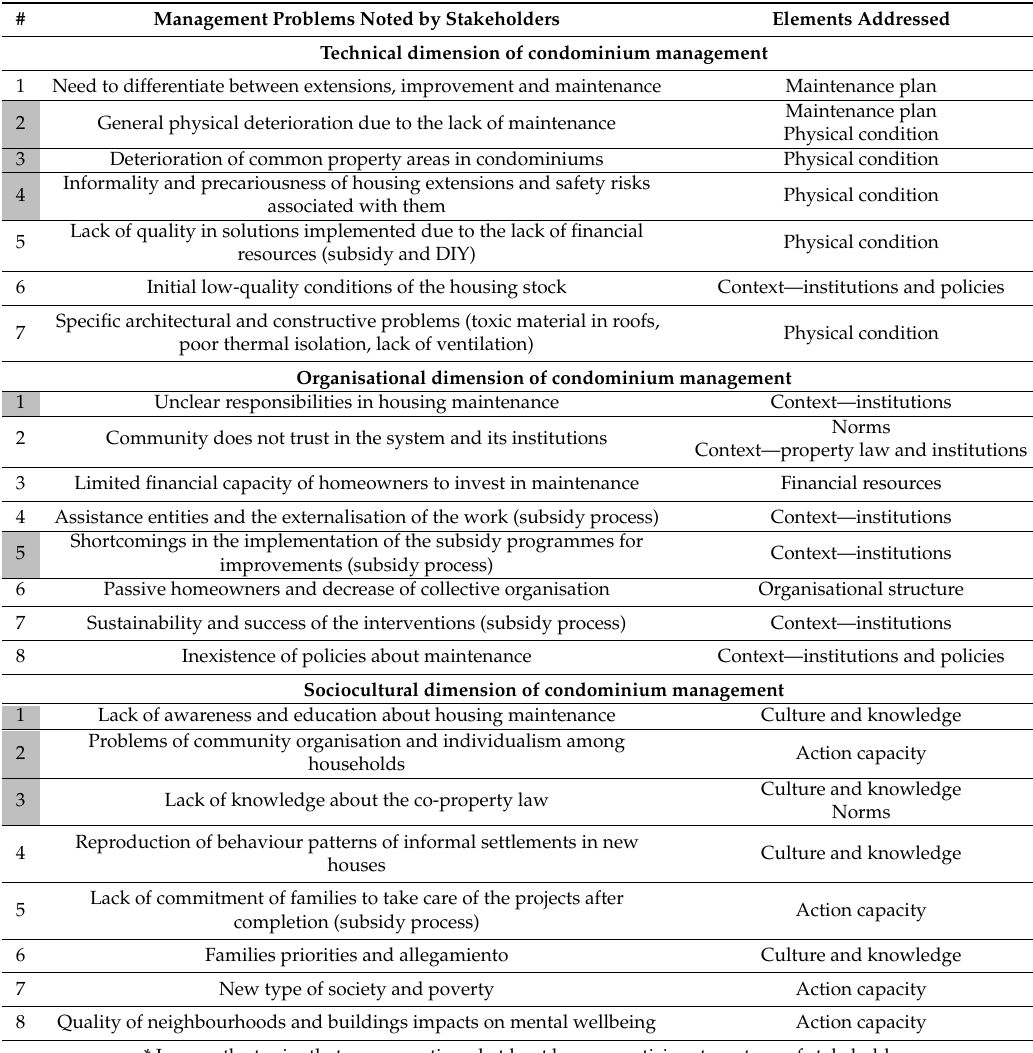
Table 5. Categorisation of housing management problems mentioned by housing professionals (from Chilean public institutions, researchers and assistance entities (PSAT) according to dimensions and